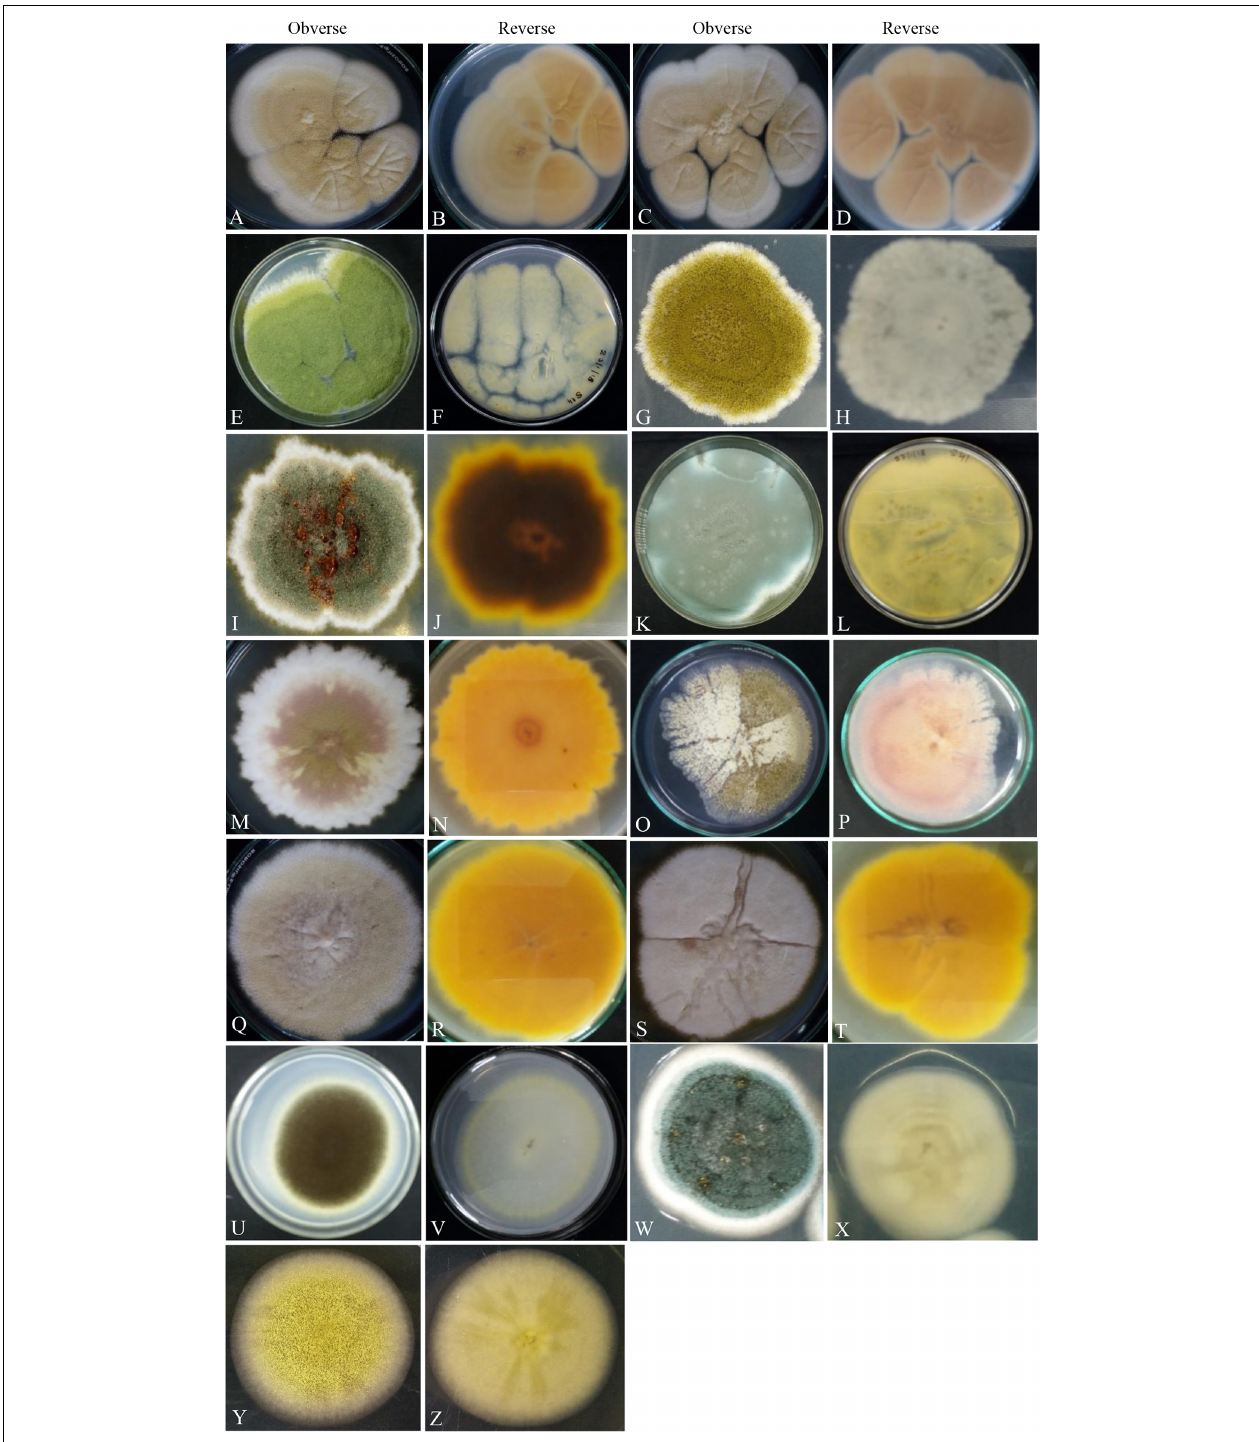
FIGURE 2 | Photographs illustrating the macromorphology of strains of Aspergillus aureoterrus (A,B) (Acc. No. MN791096); Aspergillus terreus (C,D) (Acc. No. MN791095); Aspergillus flavus (E,F) (Acc. No. MN791106); Aspergillus tamarii (G,H) (Acc. No. MN791098); Aspergillus fumigatus (I,J) (Acc. No. MN791103); Aspergillus fumigatus (K,L) (Acc. No. MN791100); Aspergillus nidulans (M–P) (Acc. No. MN791101); Aspergillus quadrilineatus/Emericella quadrilineata (Q,R) (Acc. No. MN791105); Aspergillus latus (S,T) (Acc. No. MN791110); Aspergillus awamori (U,V) (Acc. No. MN791114); Aspergillus sydowii (W,X) (Acc. No. MN298848), and Aspergillus species (Y,Z) (Acc. No. MN294688) are shown. Images (O,P) of Aspergillus nidulans were incubated in CDA for 7 days, whereas all other isolates were kept in PDA.